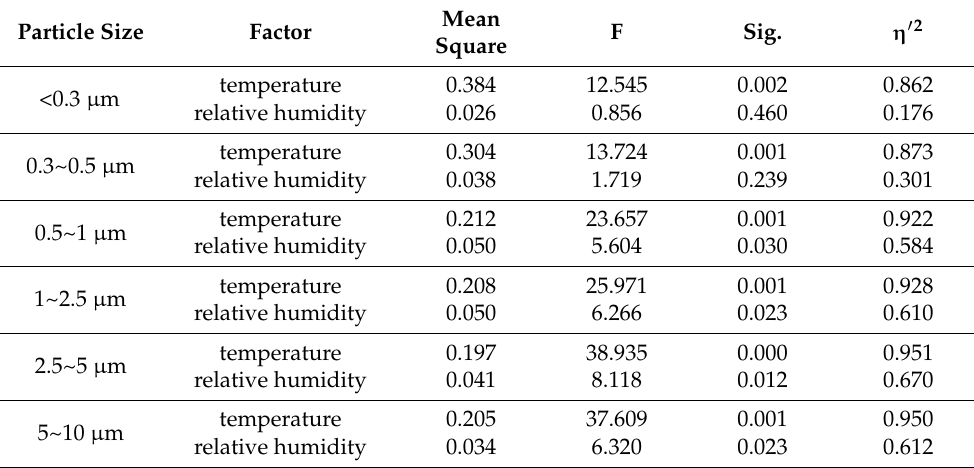
Table 4. Results of unrepeated two-way analysis of variance ( α =